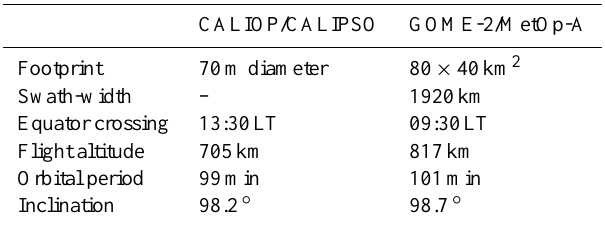
Table 4. Differences between CALIOP/CALIPSO and the GOME-